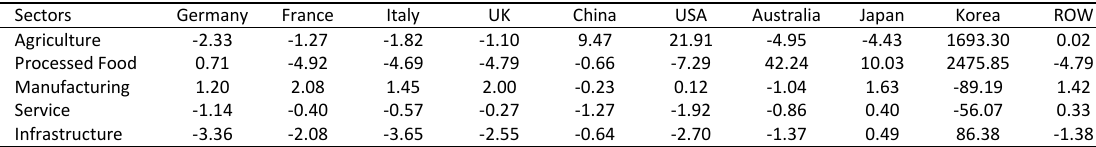
Table 4: Change in aggregate exports by sector (%)